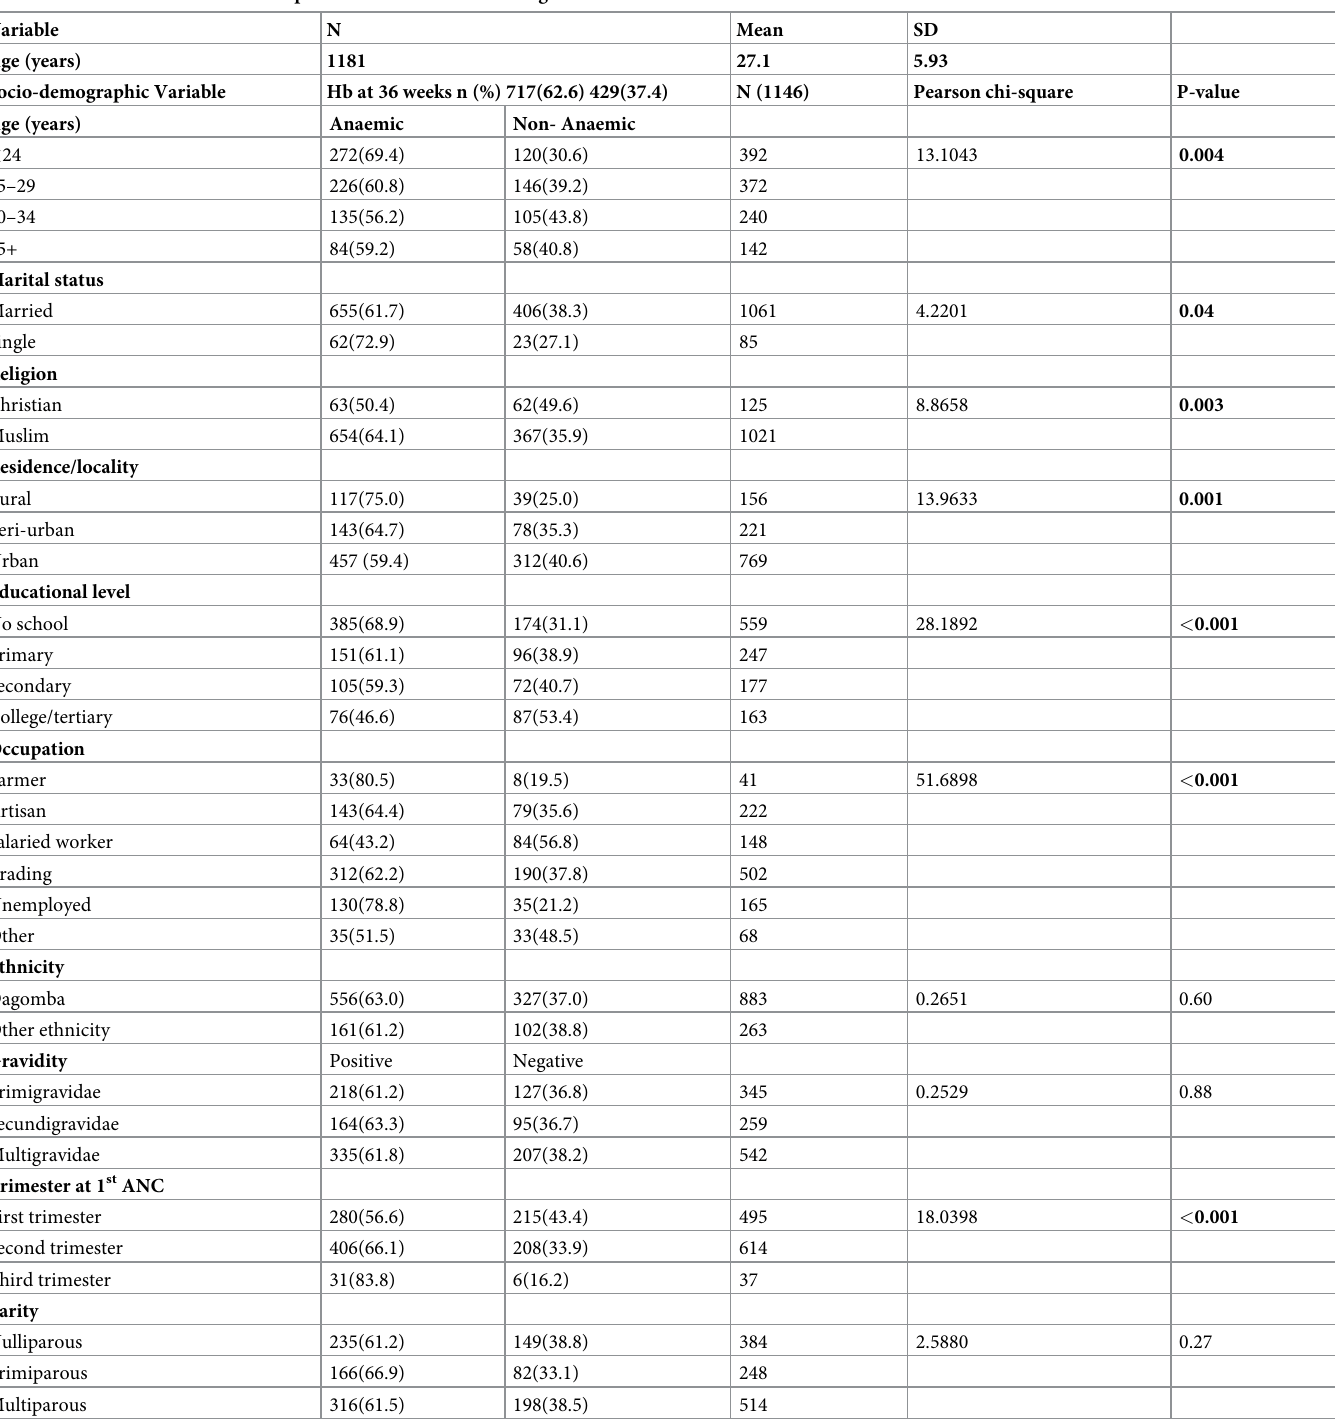
Table 1. Baseline characteristics and prevalence of anaemia in late